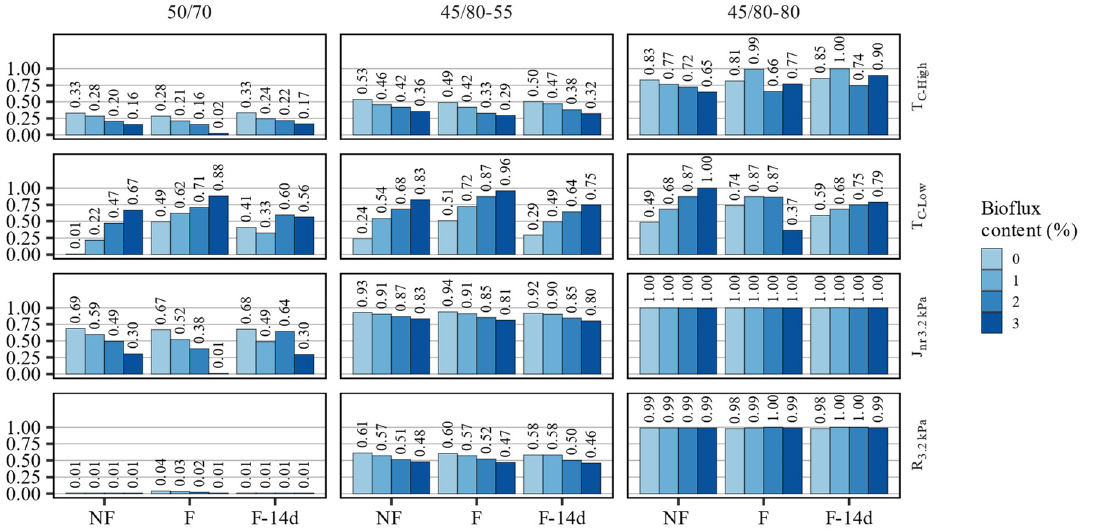
Figure 10. The computed partial desirability values with respect to the evaluated characteristics of investigated asphalt binders.